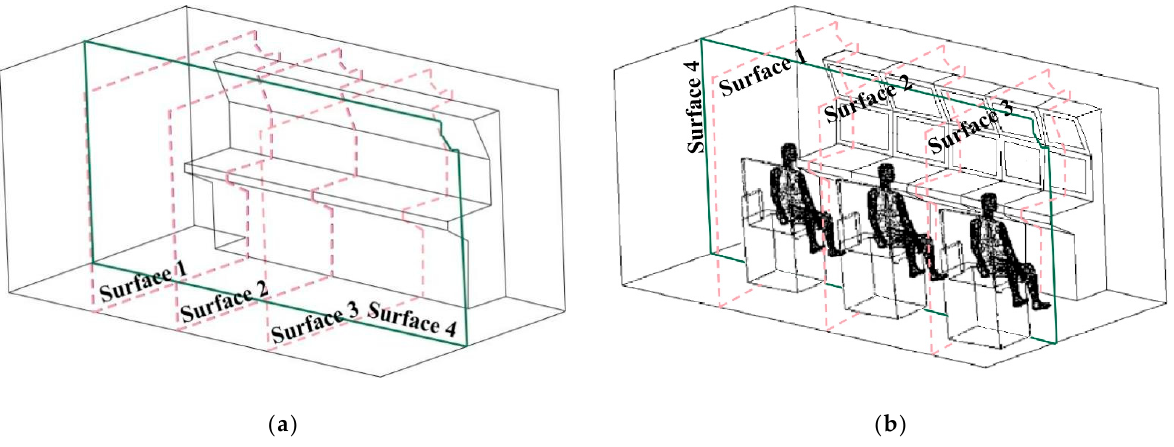
Figure 8. Measuring surfaces for manned and unmanned cabin tests. ( a ) The measuring surfaces for unmanned. ( b )The measuring surfaces for manned.